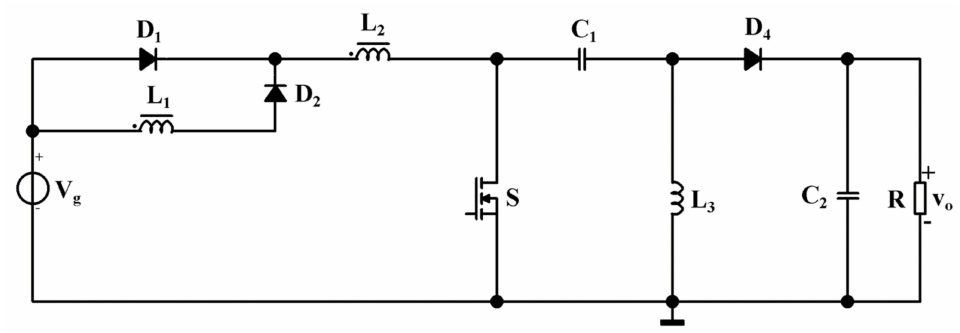
Figure 2. The proposed hybrid SEPIC-based converter with coupled inductors.